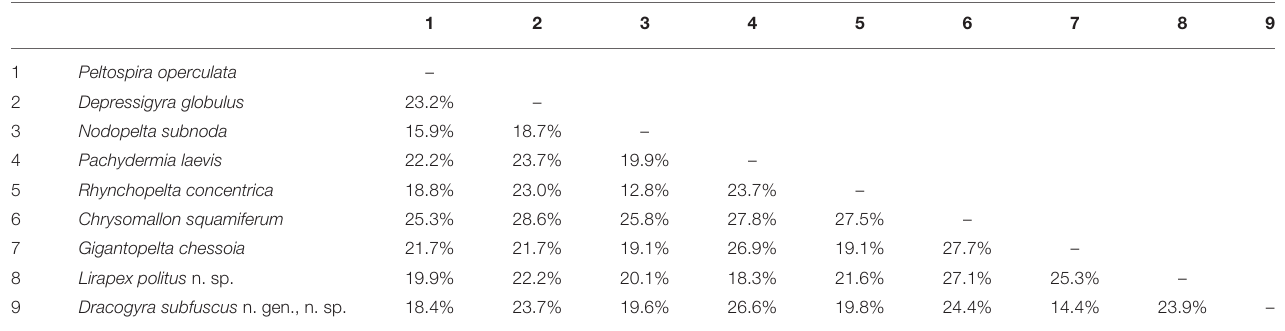
TABLE 3 | Maximum-likelihood distance matrix of nine genera in Peltospiridae, including Lirapex politus n. sp. representing Lirapex and Dracogyra subfuscus n. sp. representing Dracogyra n.